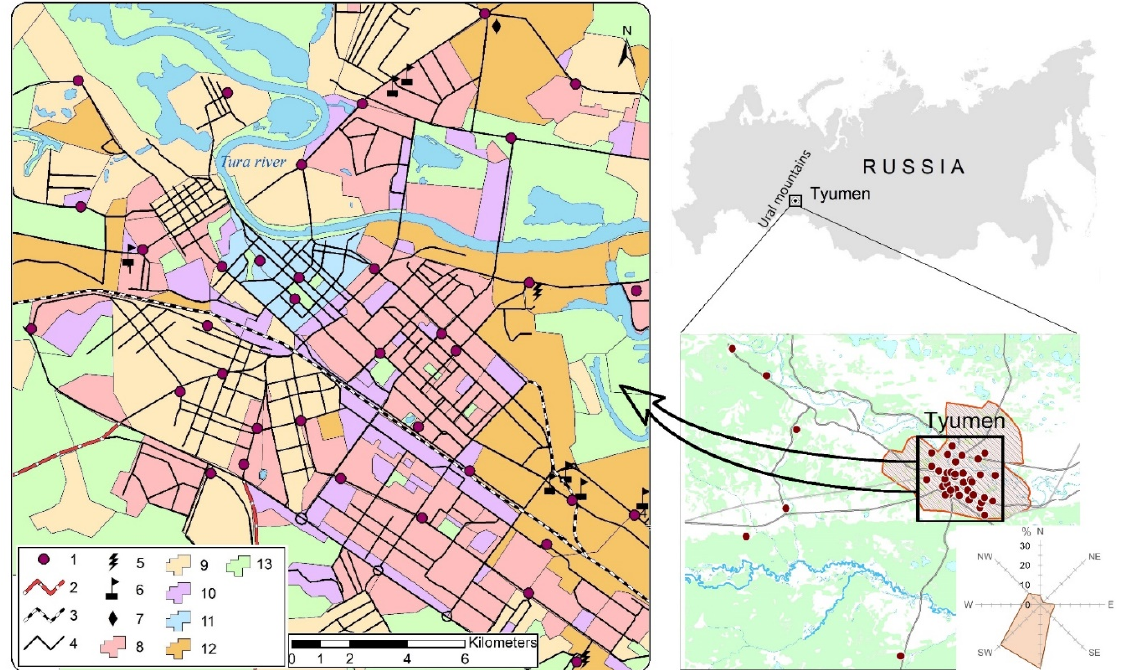
Figure 1. Sampling sites and land-use areas within the city of Tyumen, Russia: 1—sampling sites; 2—main federal roads; 3—Trans-Siberian railway; 4—main city roads; 5—power plants; 6—mechanical engineering and metalworking facilities; 7—oil refining and plastic production facilities; 8—high-rise residential area; 9—low-rise residential area; 10—modern business zones; 11—historical center; 12—industrial zones; 13—recreational and unbuilt zones. The diagram in the lower right corner shows the wind directions within the period from November 2019 to February 2020.